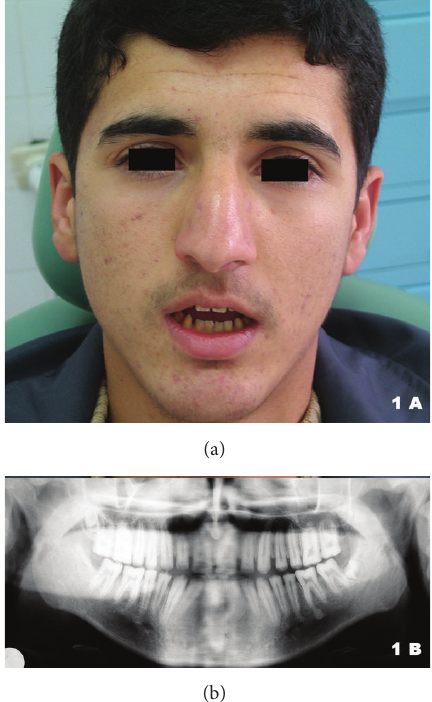
Figure 1: Facial appearance (a) and panoramic radiograph (b) of the patient before